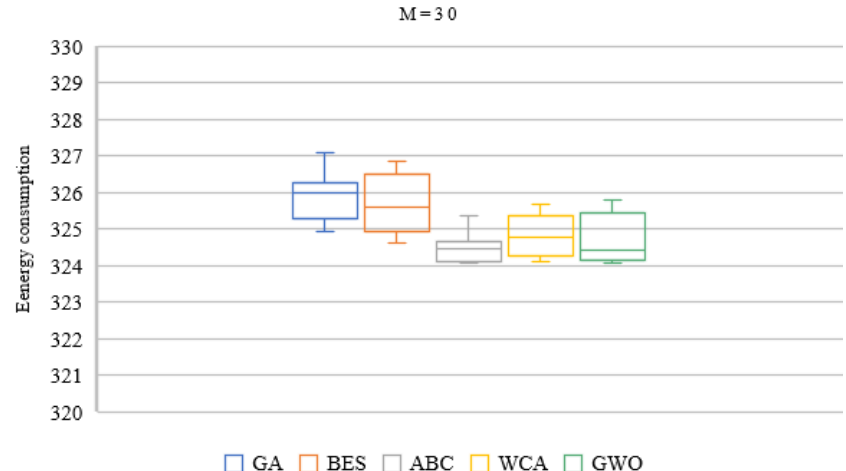
Figure 12. Box plot of the objective function at an initial population of 15.